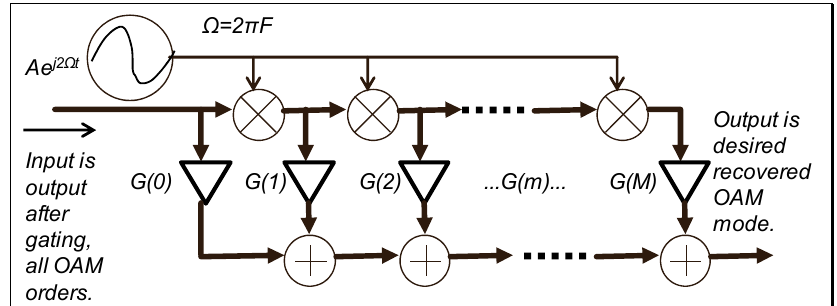
Figure A6. Direct representation of time-limited frequency-shift structure used for recovery of OAM mode.